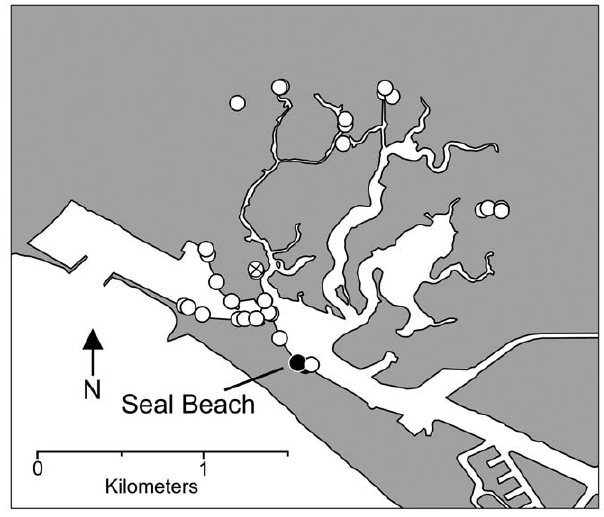
Figure 2. Locations of intertidal surveys in Anaheim Bay (California, USA) completed between 06 June 2004 and 9 December 2004. Black circles indicate locations where Littorina littorea was found; white circle with an X indicates the location where only shells (no live individuals) of L. littorea were found; open white circles are locations where L. littorea was not